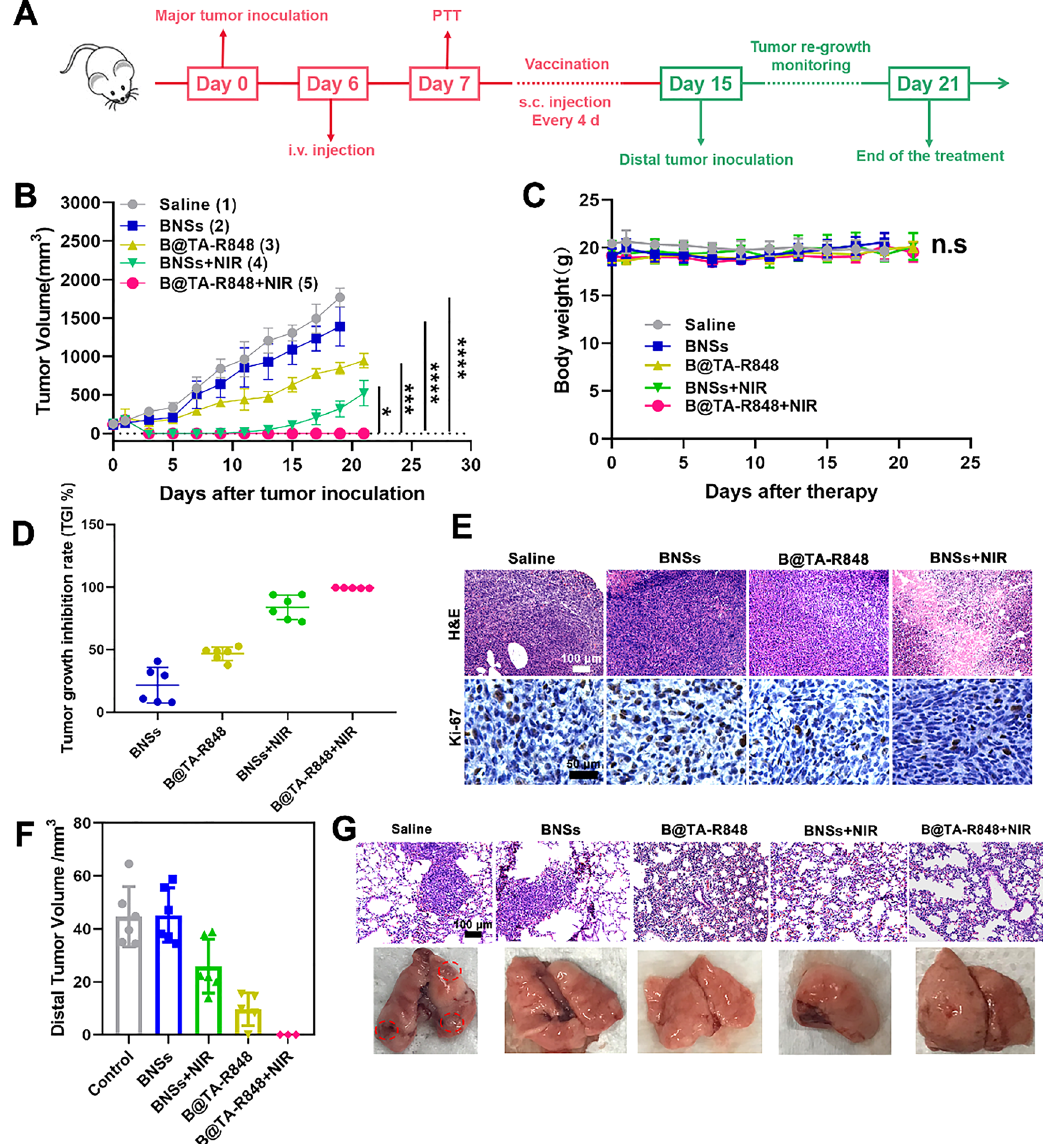
Figure 5: In vivo combined cancer therapy effect. (A)Schemeof antitumorstudy.(B)Tumorgrowthcurveof 4T1tumor-bearingmicewithvarioustreatments. (C)Bodyweightofmiceovertimeto the various treatments. (D) Tumor growth inhibition rate. (E) Representative H&E staining and immunohistochemical staining of Ki-67 in treated tumor tissues (scale bar, 100 and 50 μ m). (F) Distal tumor growth statistics in different treatment groups. (G) The H&E staining and photoimagesoflungsindifferenttreatmentgroups(scalebar100 μ m).(D,E,F) n =6;** p <0.01,*** p <0.001andns:Notsigni fi cant( p >0.05), analyzed by t -test, followed by Dunnett ’ s multiple comparisons test. Data represent mean ±